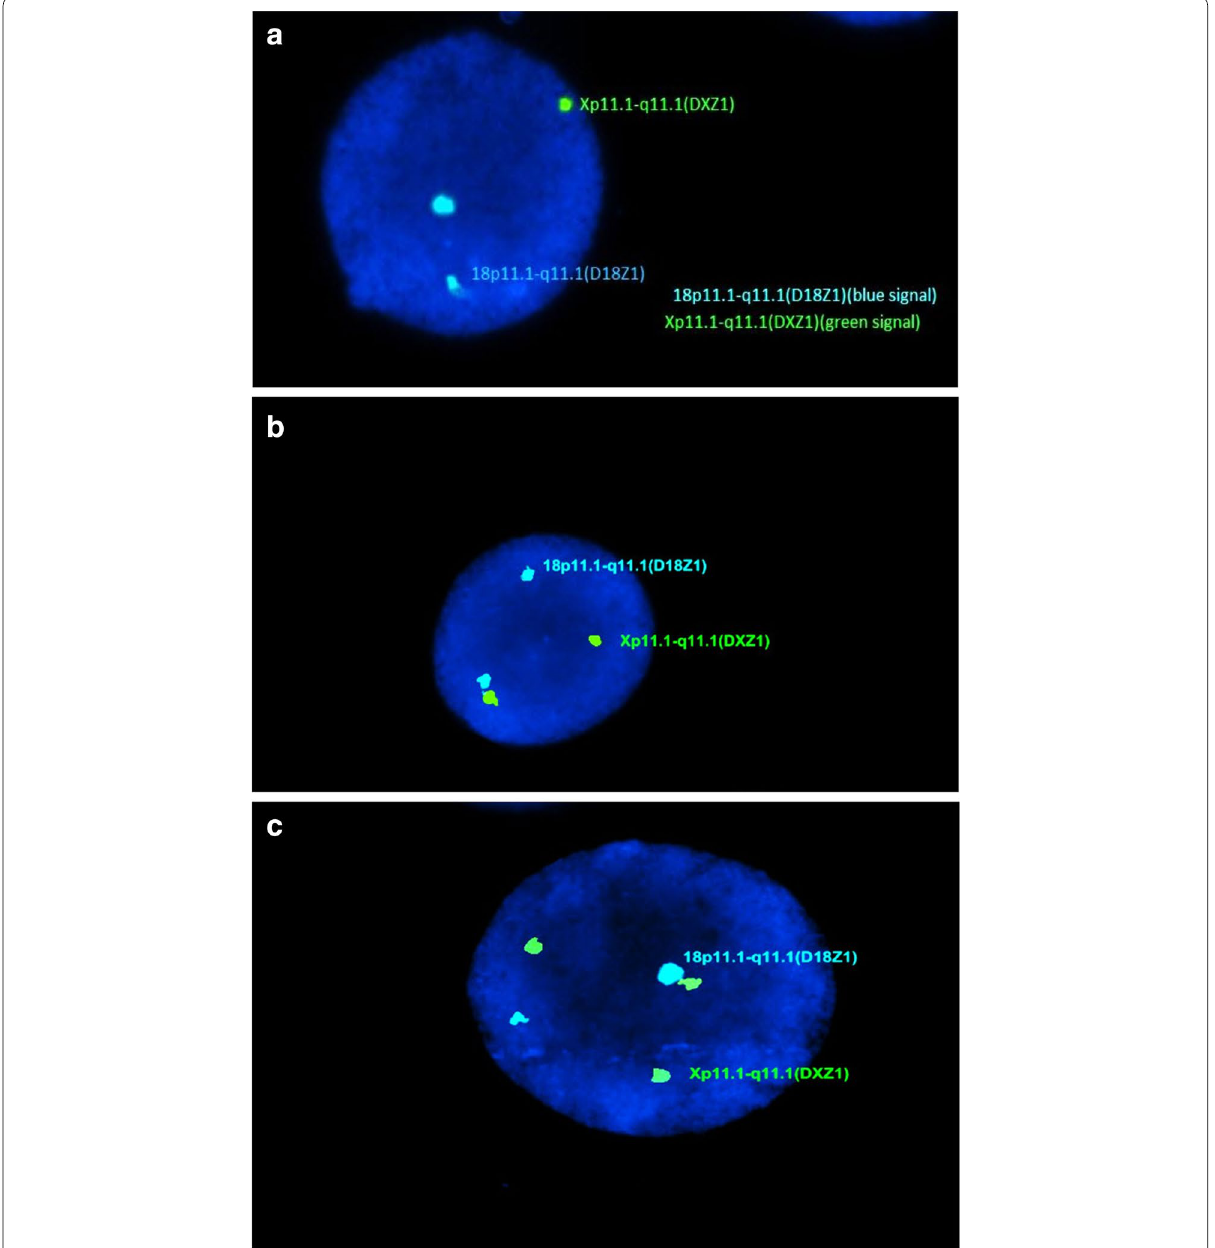
Fig. 4 FISH analysis on interphase nuclei. FISH was performed using alpha satellite probes of X (green) and and 18 (aqua) chromosomes. The images show the different categories of signals detected: a monosomy X mosaicism (one X signal and two 18 signals). b Disomy X (two X signals and two 18 signals). c Trisomy X (three X signals and two 18